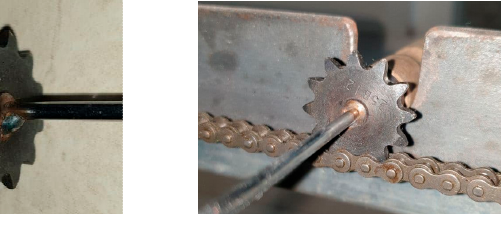
16 of 26 ( a ) Location of sprocket ‐ roller chain engagements ( b ) Top ‐ bottom roller chain link, right side ( c ) Sprocket configuration on the motor bracket ( d ) Top ‐ bottom roller chain link, left side Figure 7. Sprocket ‐ roller chain mechanism. Figure 7b–d shows the sprocket configuration that creates a link from the top plat ‐ form to the bottom platform. These links allow the rotational movement from the bottom platform to be transmitted to the top platform, thus reducing the need for individual elec ‐ tric motors for each platform. During the design phase of this project, the frame dimension and sprocket placement were designed to allow enough clearance for the movement of the roller chain. In Figure 7c, when the motor is turned on, the circled sprocket will rotate clockwise and move the entire roller chain in the direction of the arrows. Figure 8a shows the rotisserie spit of the prototype. The rod of the rotisserie spit is